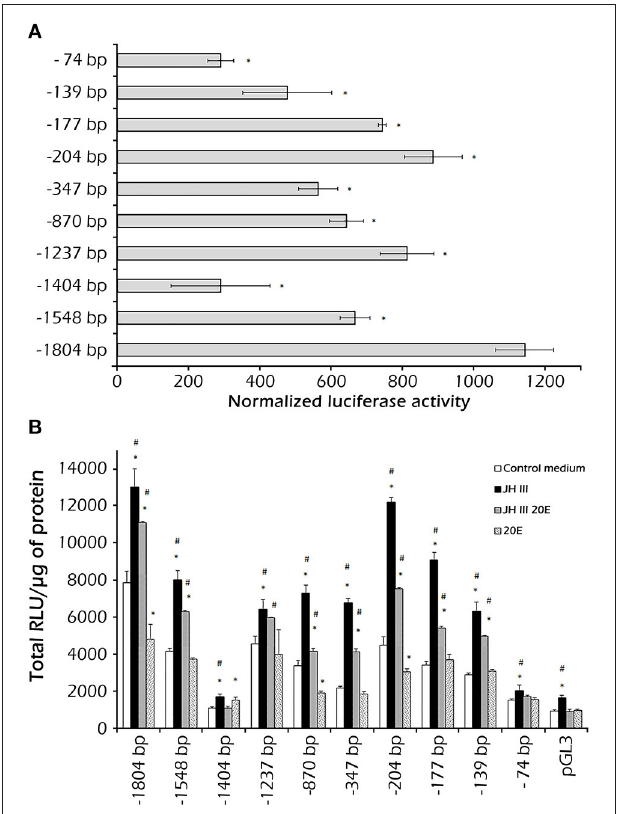
FIGURE 3 | Identification of the juvenile hormone (JH) responsive region in the Vg2 promoter. A 1,804-bp DNA fragment upstream of the TSS was isolated, and 5 ′ deletion fragments ( − 1,548, − 1,404, − 1,237, − 870, − 347, − 204, − 177, − 139, and − 74 bp) were produced by PCR and cloned into a luciferase reporter vector (pGL3). These constructs were assayed in Sf 9 cells. In this, 1 µ g of each reporter plasmid construct was transfected with 3 µ l of Tfx TM − 20 reagent. After 12h, the cells were treated with medium alone or medium with 1 µ M JH III, 1 µ M 20E, or 1 µ M JH III, and 1 µ l 20E. Luciferase activity was assayed 48h after treatment. (A) The assay was performed using the Bright-Glo TM Luciferase Assay System (Promega) and results were normalized against Renilla luciferase activity and plotted as relative luciferase activity (RLA); each experiment was repeated three times. Values are presented as the mean ± SD. (B) For each reporter plasmid construct, luciferase activity was assayed 48h after the addition of hormones JH III, 20E, and both JH III and 20E mixture. Data are presented as mean ± SD. Bars marked with * or # are significantly different ( P < 0.05) as compared to the media (control media without hormones) or the combined JH III and 20E treatment, respectively.